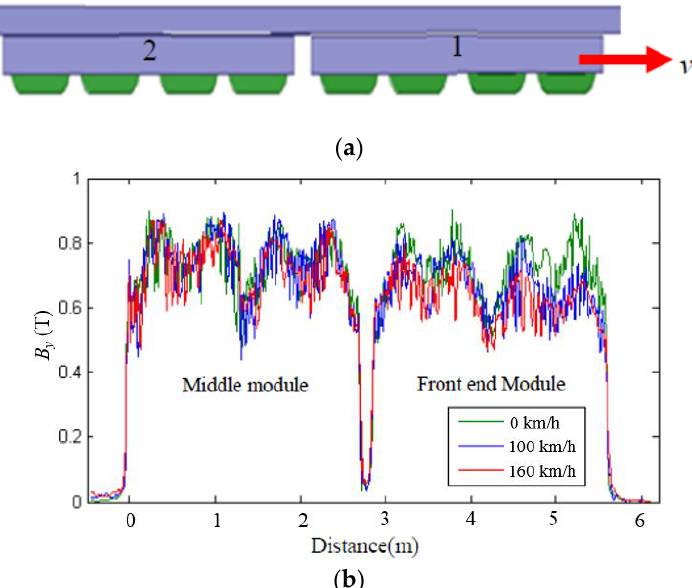
Figure 4. FEM model and air-gap flux density of two electromagnet modules at different speeds: ( a ) The FEM model of two electromagnet modules; ( b ) Air-gap flux density along with longitudinal direction.